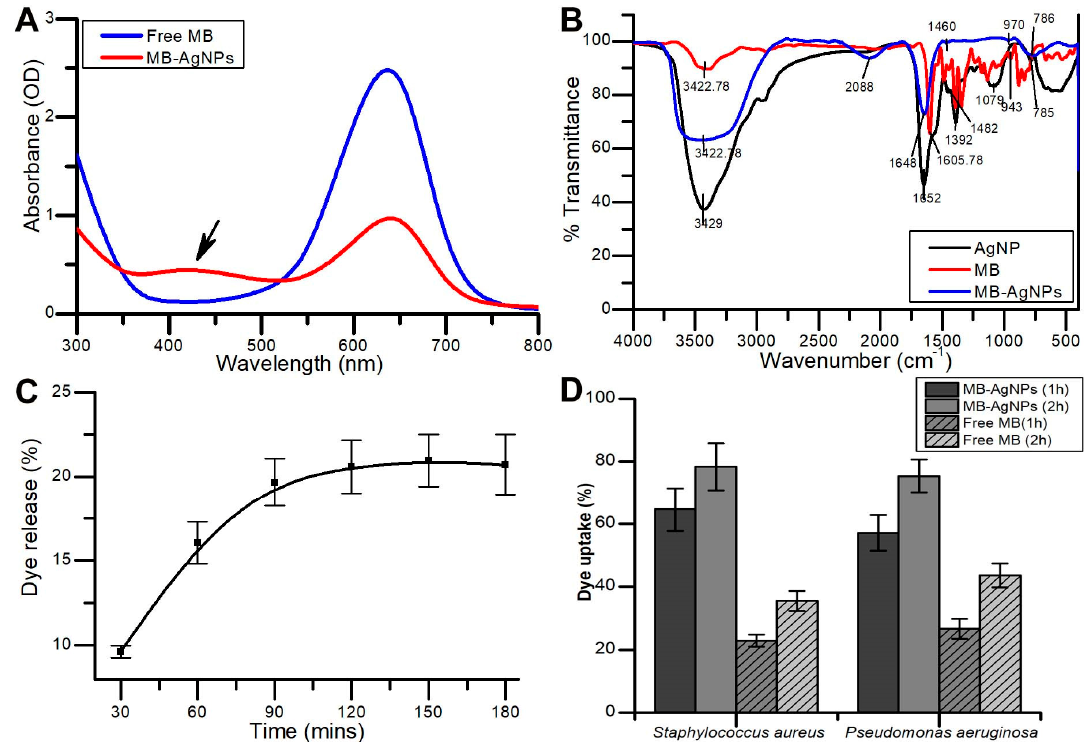
Figure 4. ( A ) UV-Visible absorption spectrum representing the characteristic peaks of AgNPs, methylene blue (MB), and MB-AgNPs. ( B ) Functional groups of AgNPs, MB, and MB-AgNPs are recorded on a FTIR spectrum. ( C ) Release profile of dye from MB-AgNPs studied through in vitro dye release study. ( D ) Bacterial uptake of MB from free MB and MB-AgNPs.